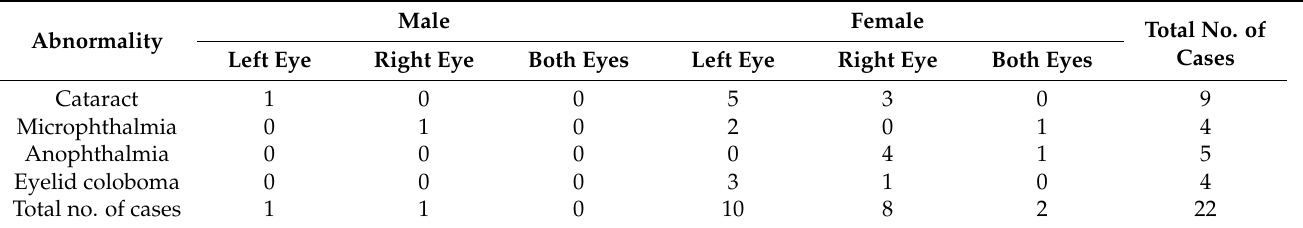
Table 1. Number of eye abnormalities observed in 17 mice of the PBF2